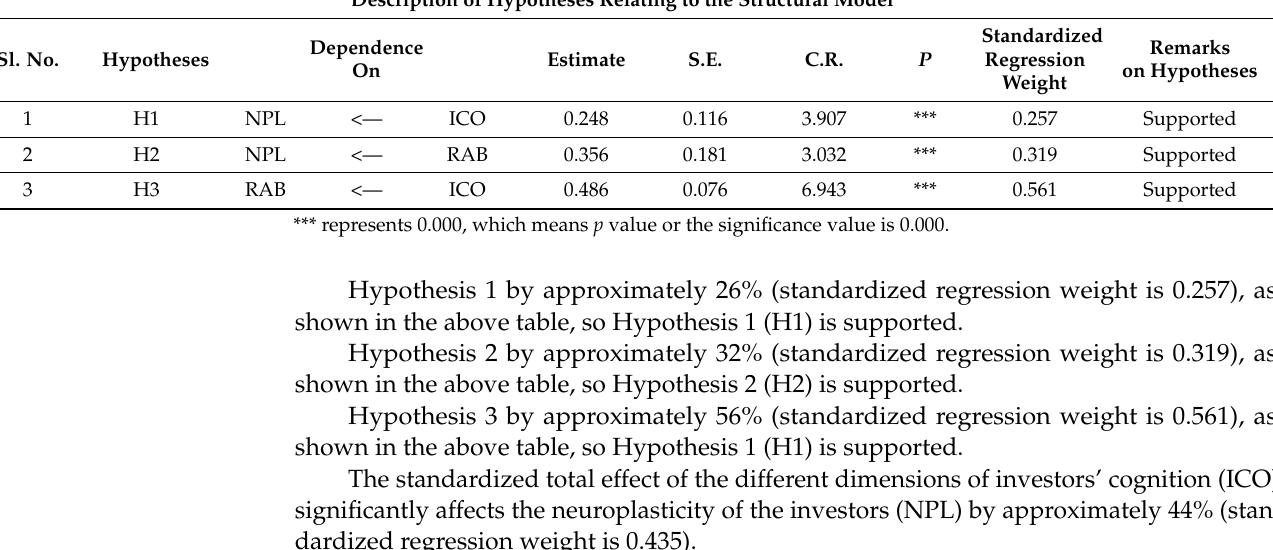
Table 3. Relation among the latent variables (direct and mediating effects of independent variables on the dependent